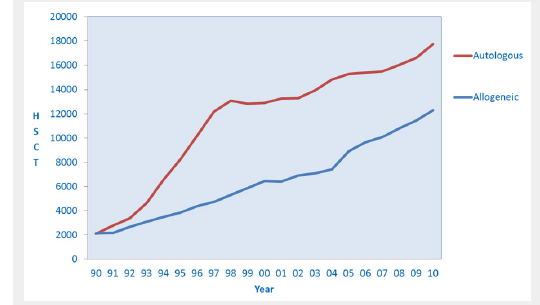
Autologous and Allogeneic HSCT in Europe 1990–2010 (reprinted from: Passweg JR, Baldomero H, Gratwohl A, Bregni M, Cesaro S, Dreger P, et al.; for the European Group for Blood and Marrow Transplantation (EBMT). The EBMT activity survey: 1990–2010. Bone Marrow Transplant. 2012;47(7):906-23